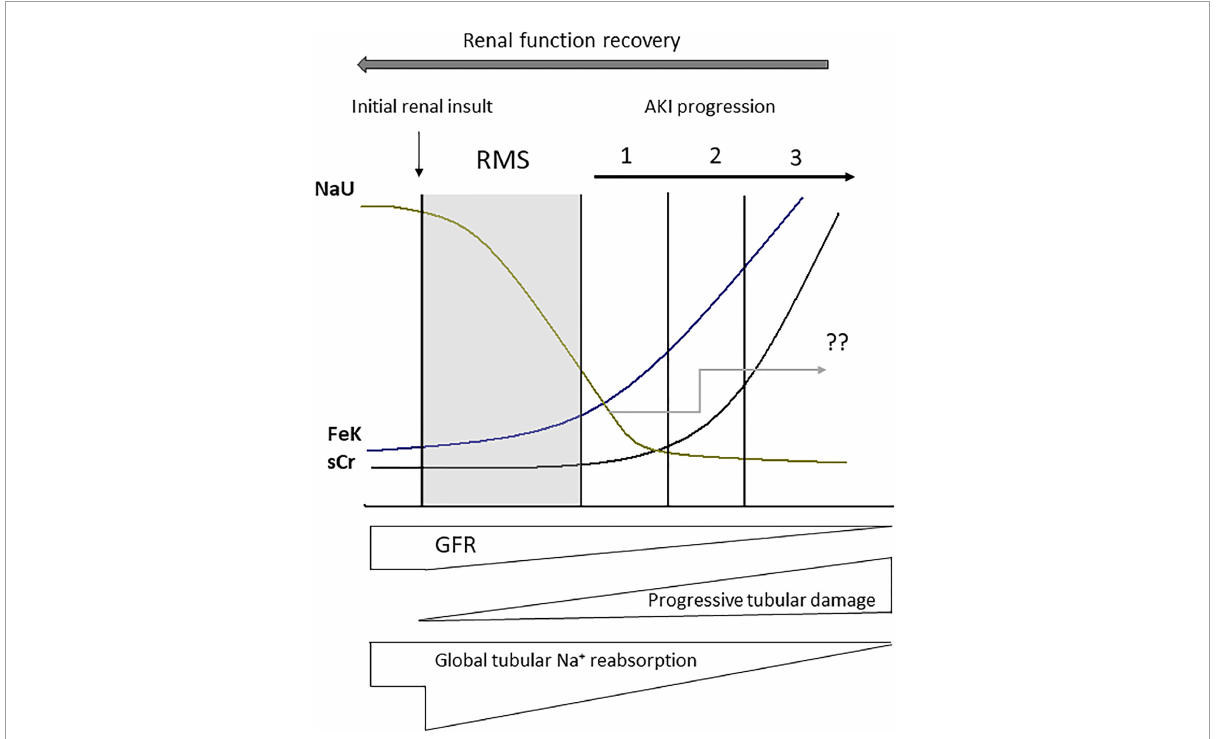
FIGURE4 Urine biochemistry behavior after renal microcirculatory stress (RMS) has been triggered by a renal insult (macro or microcirculatory). Abrupt decreases in urine sodium concentration (NaU) as well as increases in the fractional excretion of potassium (FeK) occur before augmentation in serum creatinine (sCr). NaU value after acute kidney injury (AKI) diagnosis is quite variable because it depends on the magnitude of the reduction in glomerular filtration rate (GFR) in combination with the magnitude of tubular damage and impairment of tubular sodium reabsorption, as well as some degree of tubular sodium backleak (“??” represents NaU variability and unpredictability in the Figure). Nonetheless, in the context of AKI, NaU is not expected to reach very high values ( > 140 mEq/L). These values would only be found after renal function recovery. 1, 2, and 3 correspond to progressive stages of AKI